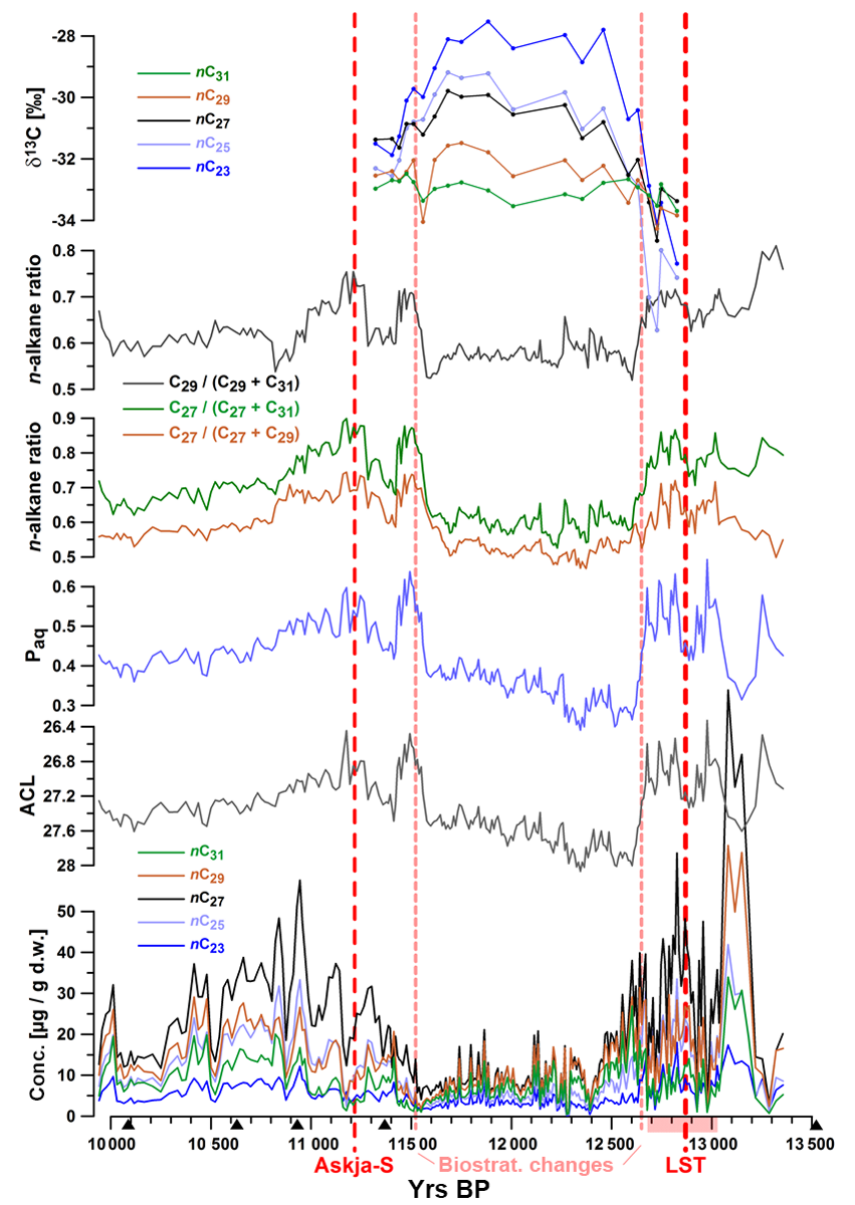
Figure 2. Concentrations of n -alkanes, average chain length (ACL), P aq , n -alkane ratios, and δ 13 C values plotted versus age. Red dotted lines mark occurrences of tephra layers Askja-S (A-S: 11228 ± 226yrBP) and the Laacher See Tephra (LST 12880 ± 40yrBP) and the biostratigraphic change at 1183.5cm of depth (11515 ± 35yrBP). Black triangles mark 14 C AMS ages. The pink shaded interval on the x axis illustrates the laminated core